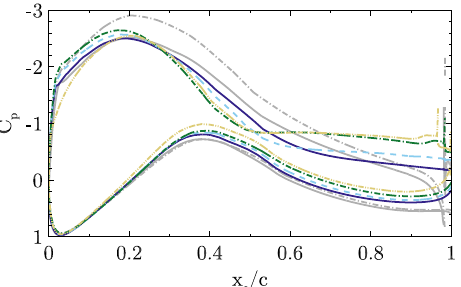
Figure 17. Airfoil pressure distribution at r/R = 0 . 136 for CaseT1.0 (solid), CaseT1.2 (dashed), CaseT1.4 (dashed dot) and CaseT1.4-twistmod (dashed dot dot). The gray curves denote corre- sponding inviscid simulations.